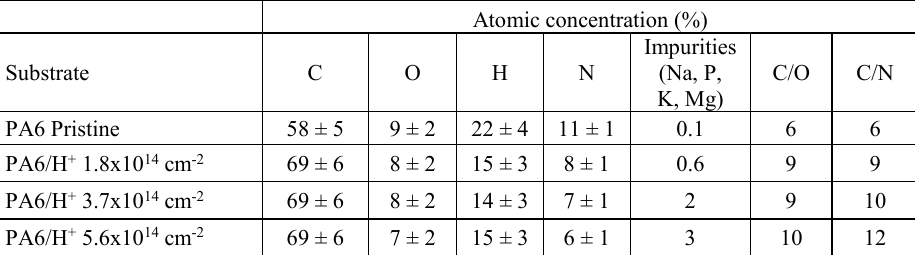
Table 3. The PA6 stoichiometry before and after the H-ion irradiation determined using RBS and ERDA methods.